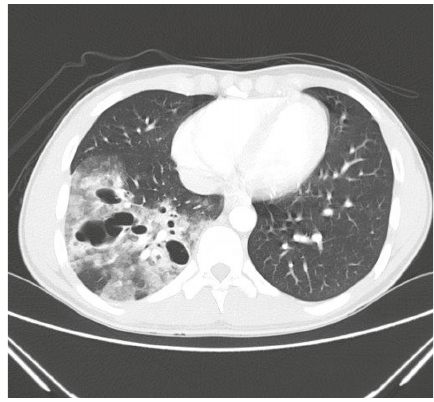
Figure 2: CT scan of the chest showing thick-walled multicystic lesions with patchy air space opacities.